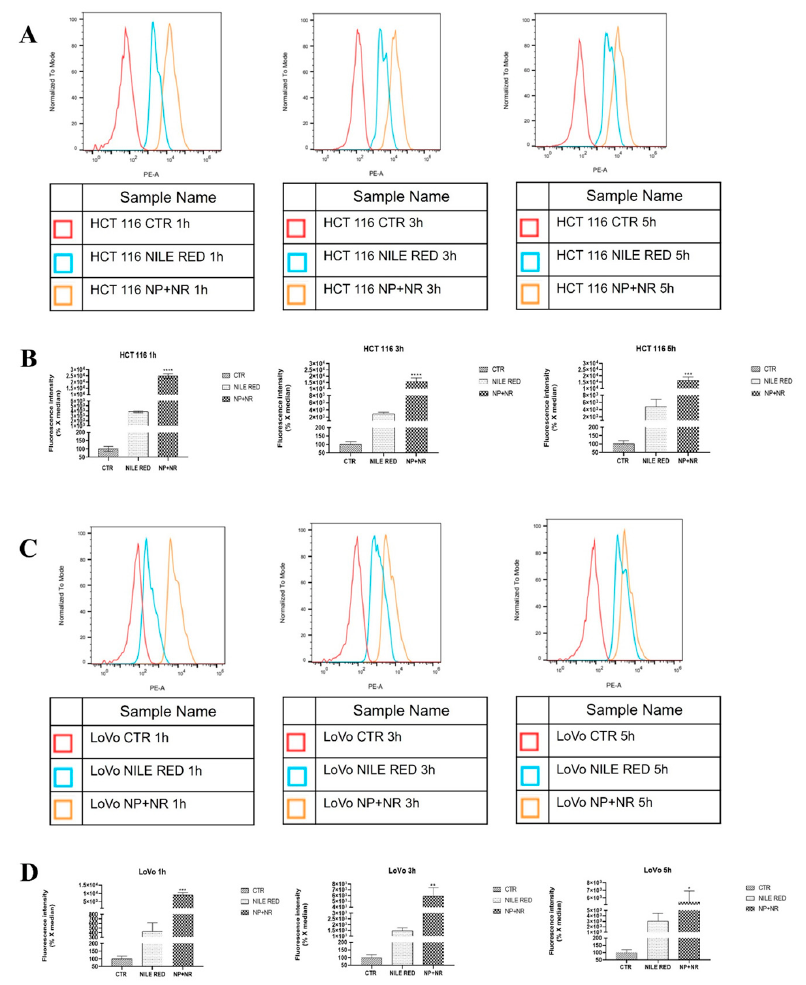
Figure 6. FACS analysis of nanoparticle uptake in colorectal cancer cell lines. Graphical representation of cellular NR uptake evaluated by flow cytometry in HCT 116 ( A ) and LoVo ( C ) cells after 1 h, 3 h, and 5 h of incubation, at the absorption peak at 590 nm wavelength (PE-A). Bar graphs reported the median X% of NR fluorescence intensitv in HCT 116 ( B ) and LoVo ( D ) cell lines. The experiments were performed at least three times and the results were always similar. Bars, SD. (* p < 0.05; ** p < 0.005; *** p < 0.001; **** p < 0.0001 vs. negative control).